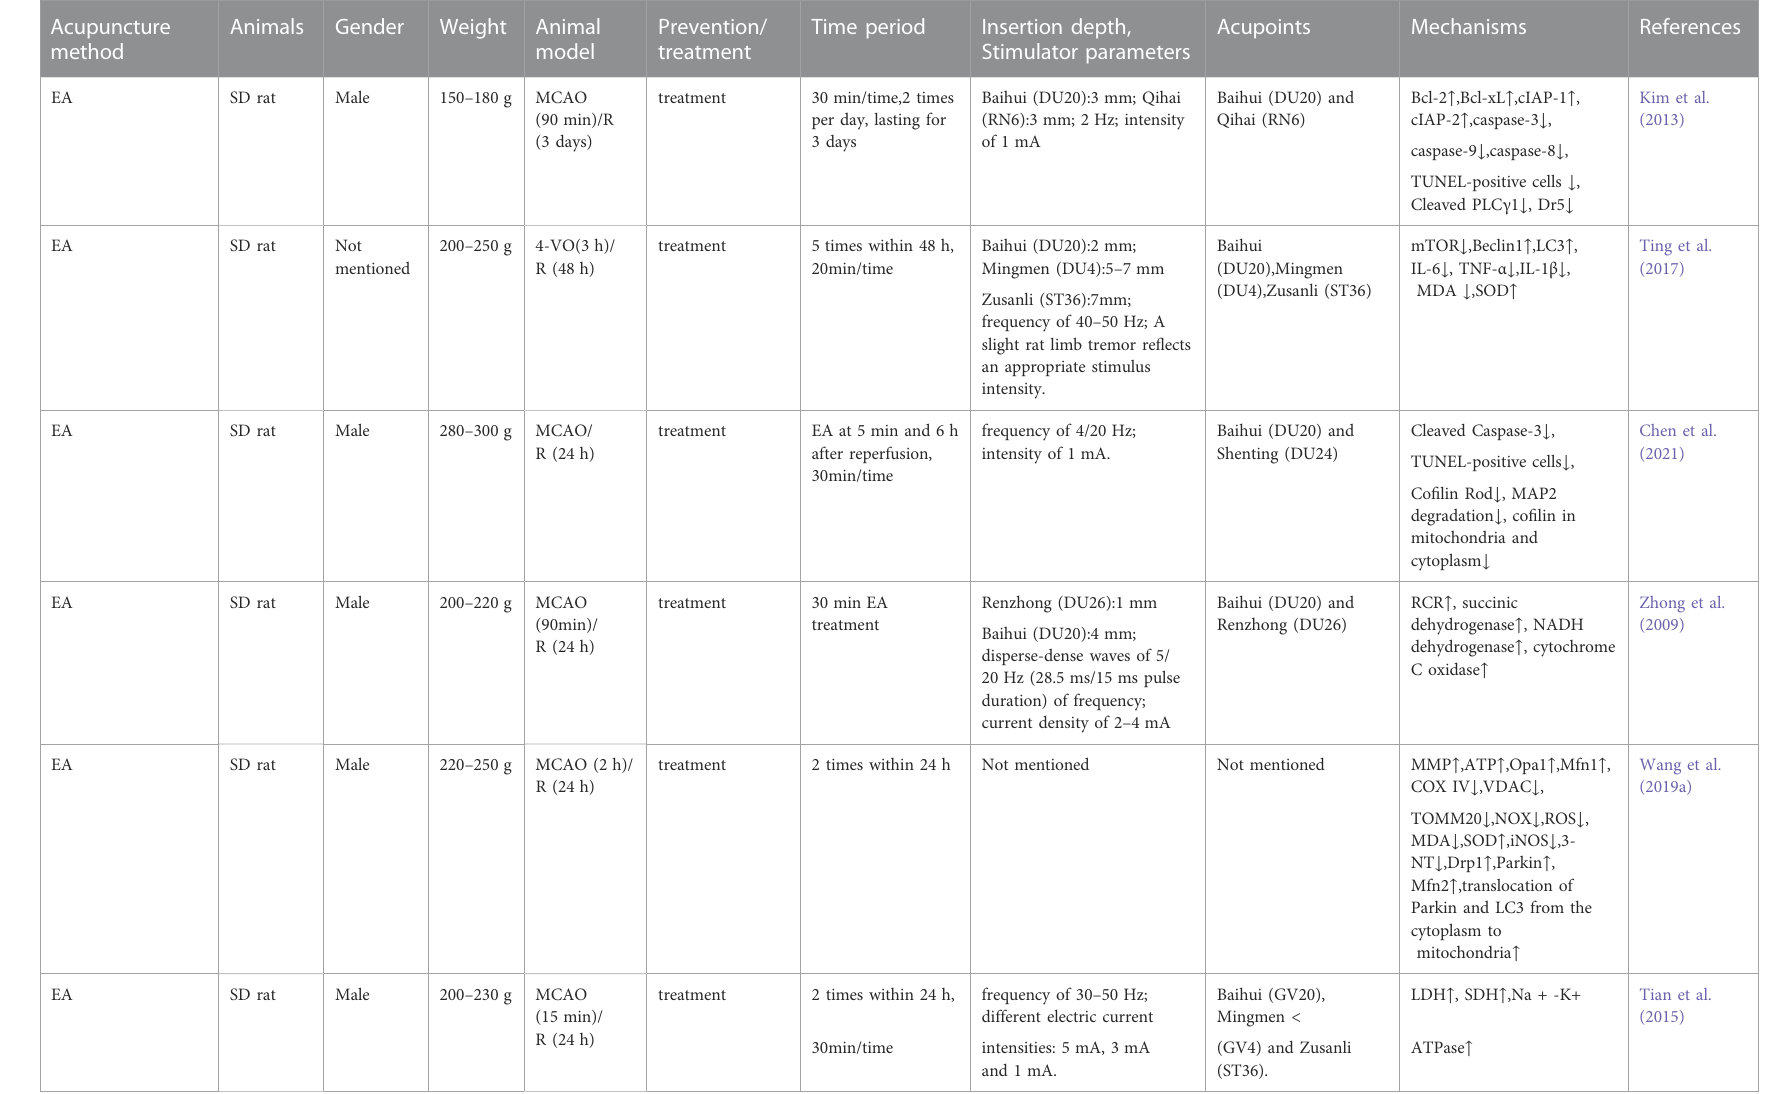
TABLE 1 ( Continued ) The molecular mechanism of acupuncture in the treatment of ischemic stroke by targeting